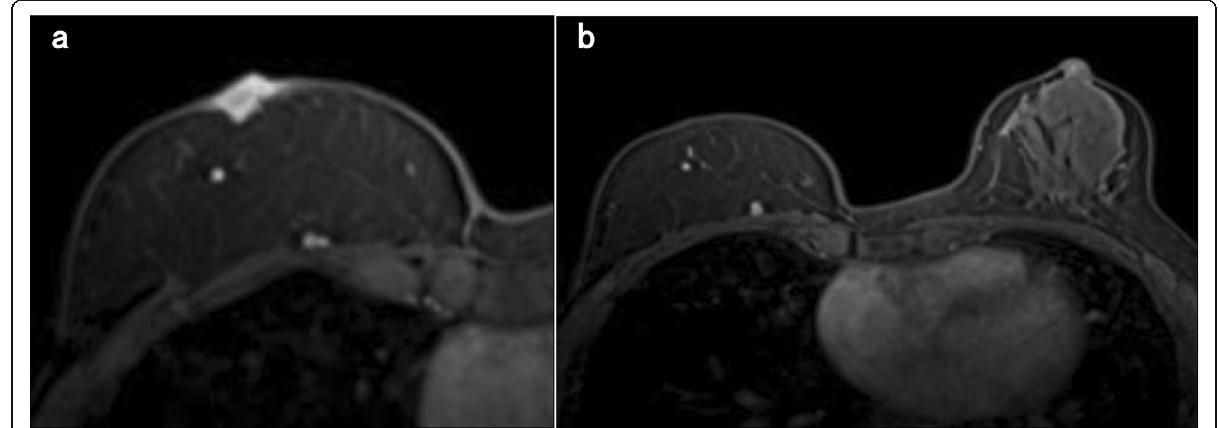
Fig. 2 a Magnetic resonance imaging (MRI) shows enhancement of the lesion of the right nipple and slight subcutaneous adipose tissue. b There is no abnormal enhancement in the left